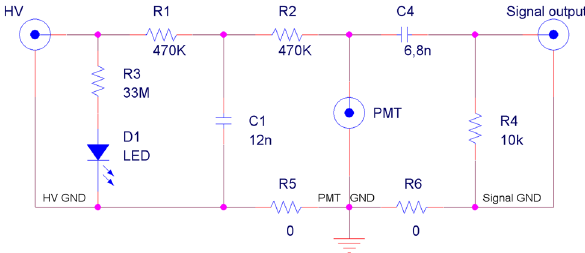
Fig. 19 Splittercircuitdiagram.R5andR6areforon-sitemodification of ground connection resistance for possible ground-loop